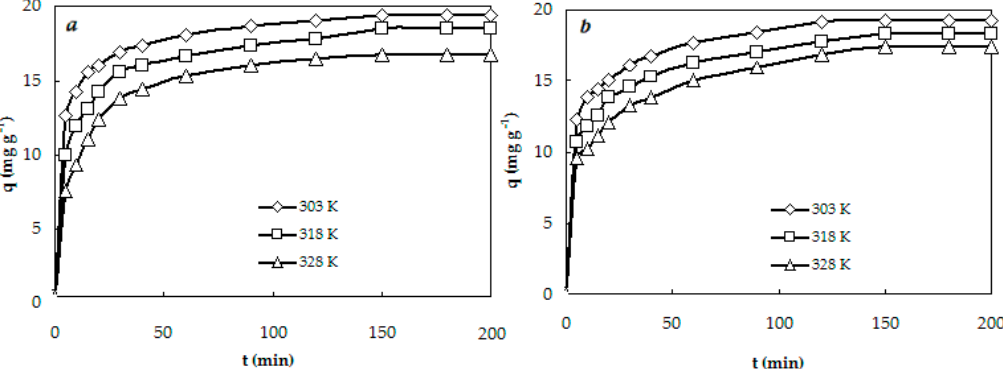
Figure 3. Kinetic adsorption curves of anionic dyes AR ( a ) and AO ( b ) on CS-CP at different temperatures.